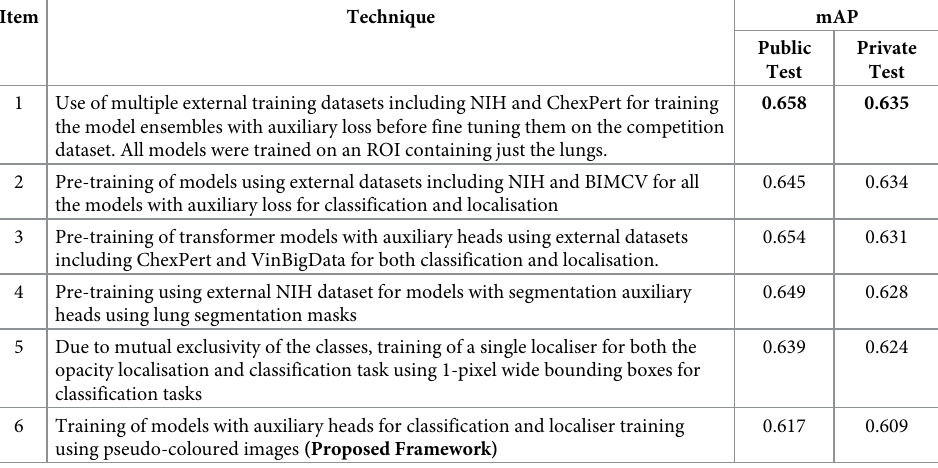
Table 7. Comparison with top scoring methodologies on [41].